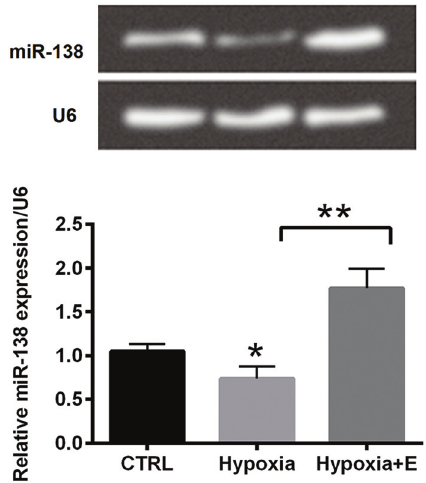
Figure 3. Relative expression of miR-138 was inhibited by hypoxia treatment but then increased by emodin (E) treatment detected by quantitative real-time polymerase chain reaction. Data are reported as means ± SD of triplicates. Each experiment was performed three times. *P o 0.05, **P o 0.001 compared to con- trol or as indicated (one-way analysis of